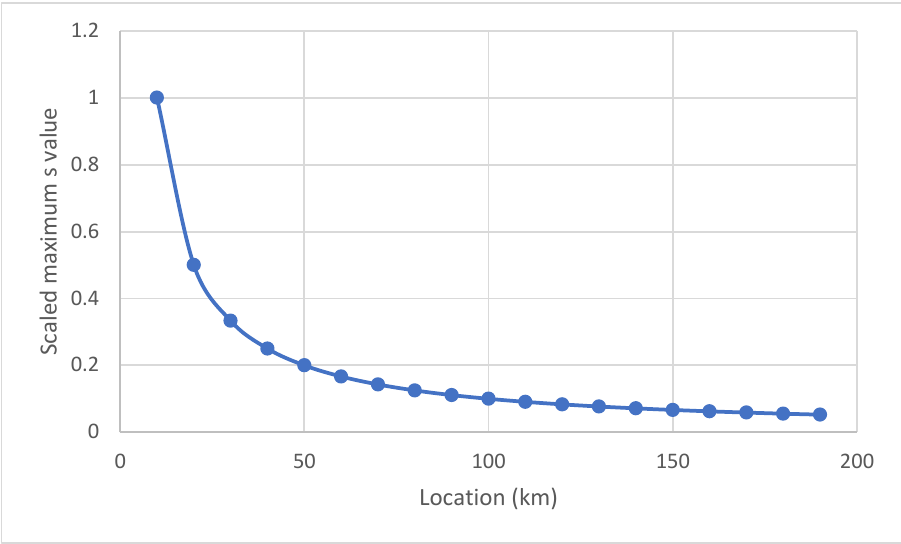
Figure 6. The best fitting curve at 19 fault locations for LG fault using scaled maximum singular value.